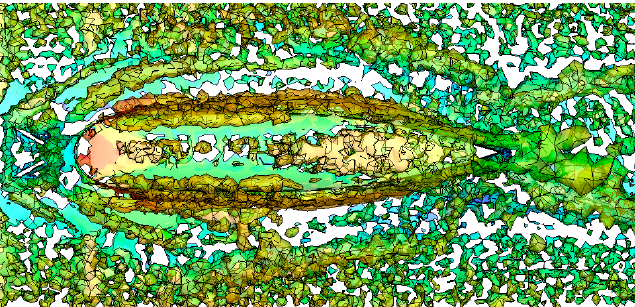
Figure 21. The vortex quanta from the model with triangular VGs at a distance of 0.1c from the leading edge of the sail hull.